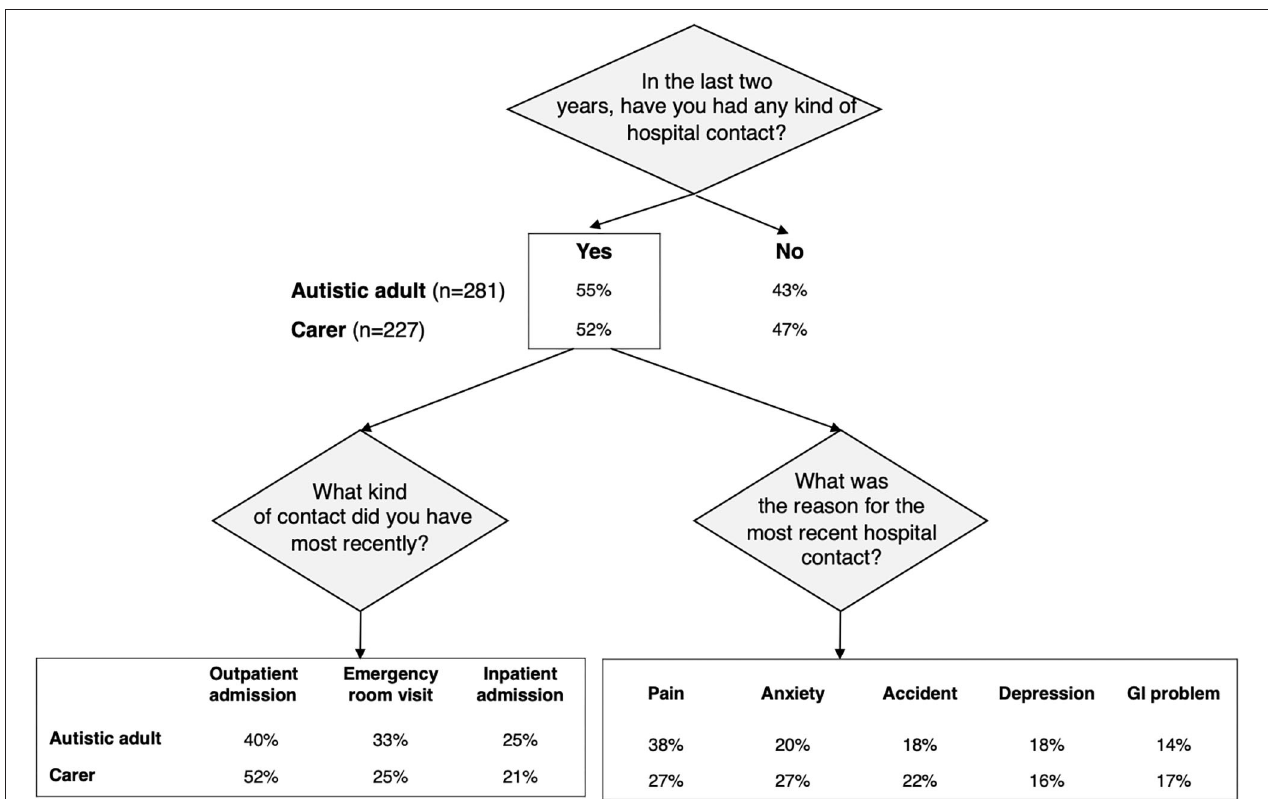
FIGURE 3 | Characteristics of the autistic adult’s most recent hospital contact in the last 2 years. GI, gastrointestinal. Flowchart summarizing percentages of positive responses given by the autistic adults and carers to the survey section related to the type/reason for most recent hospital contacts. “Do not know” answers are not